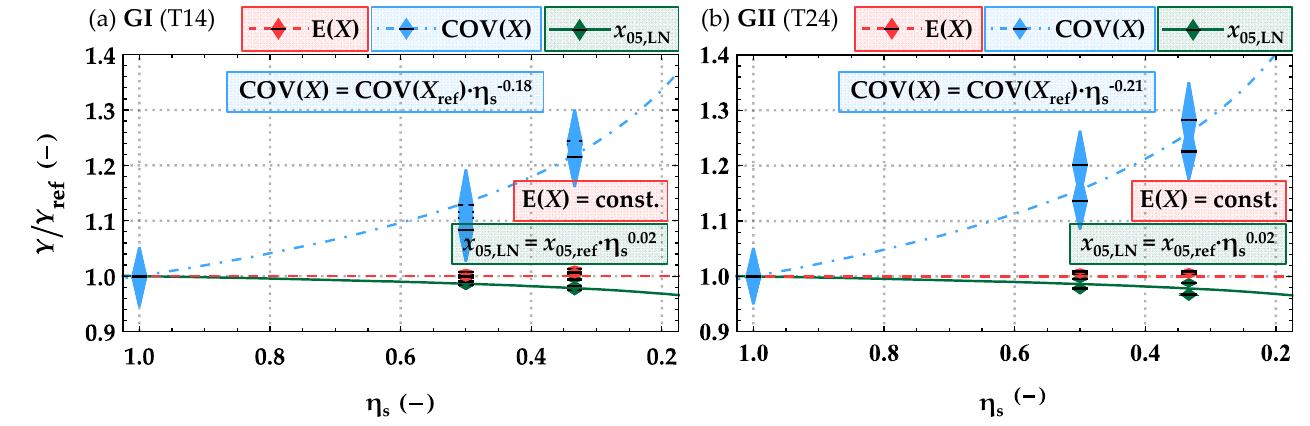
Figure 22 shows the development of the main statistics for the modulus of elasticity in bending from resawn glulam beams relative to that of glulam beams in full cross-section ( η s = 1). Constant mean values together with increasing coefficients of variation and conse- quently slightly reduced 5%-quantile values are observed for decreasing separation ratios. The constant mean values E m,g,mean are in line with the results reported in Viguier et al. [16] and Crocetti [15].